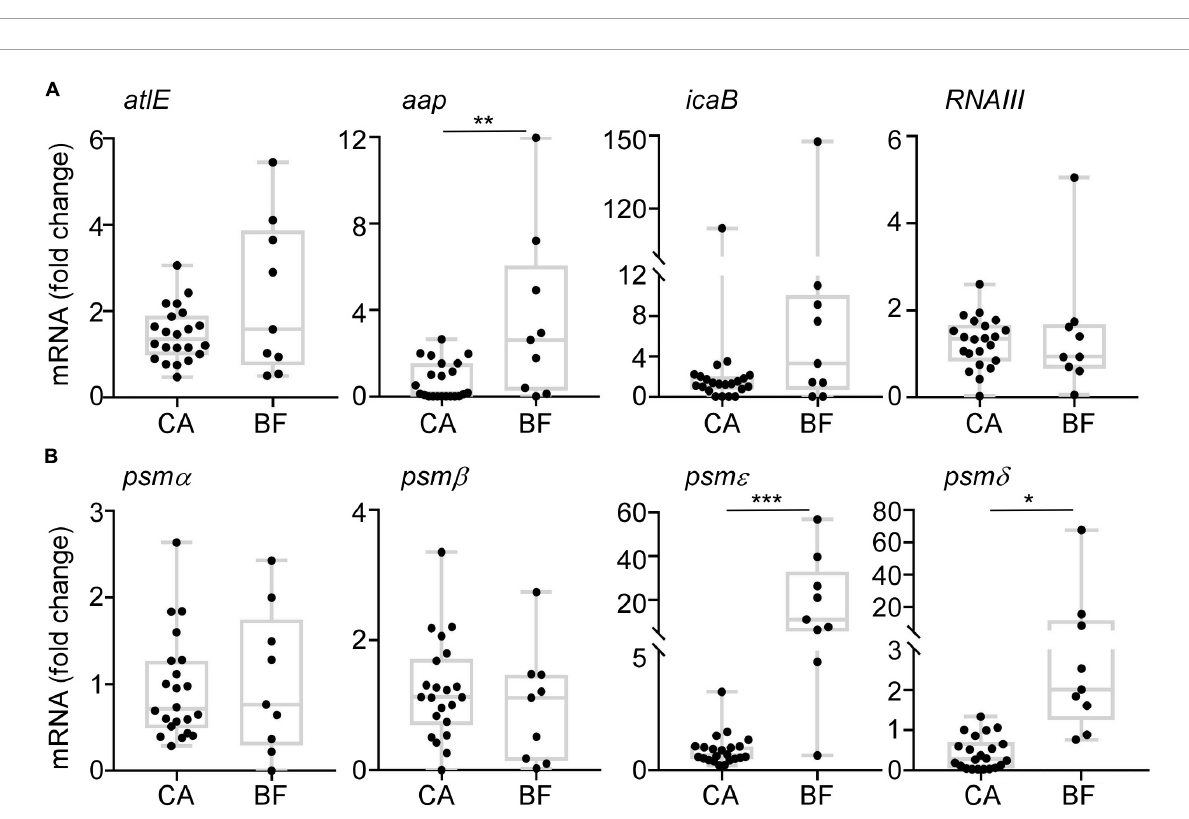
FIGURE5 The transcription profiles of biofilm-associated gens. Cells were grown in TSB to stationary growth phase (OD 600 = 2); then, the transcript levels were determined by qRT-PCR for atlE , aap , icaB , RNAIII , and PSM genes. The statistical significance was measured by unpaired, two-tailed t -test (* p < 0.05; ** p < 0.01; *** p <